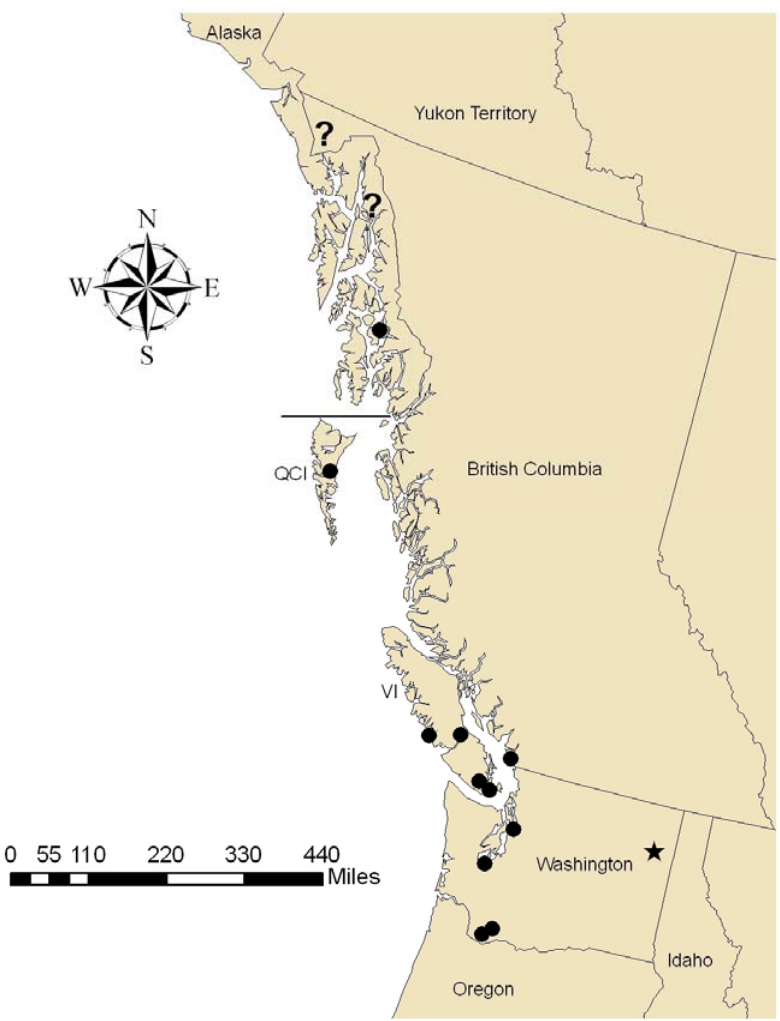
Figure 1 . Distribution of Opiona columbiana . Dots, known records; question marks, localities awaiting confirmation; star, Spokane, Washington, locality. The southernmost dot on Vancouver Island (VI) encompasses both the Victoria and Rocky Point localities; that on the QCI encompass both the Queen Charlotte City and Skidegate